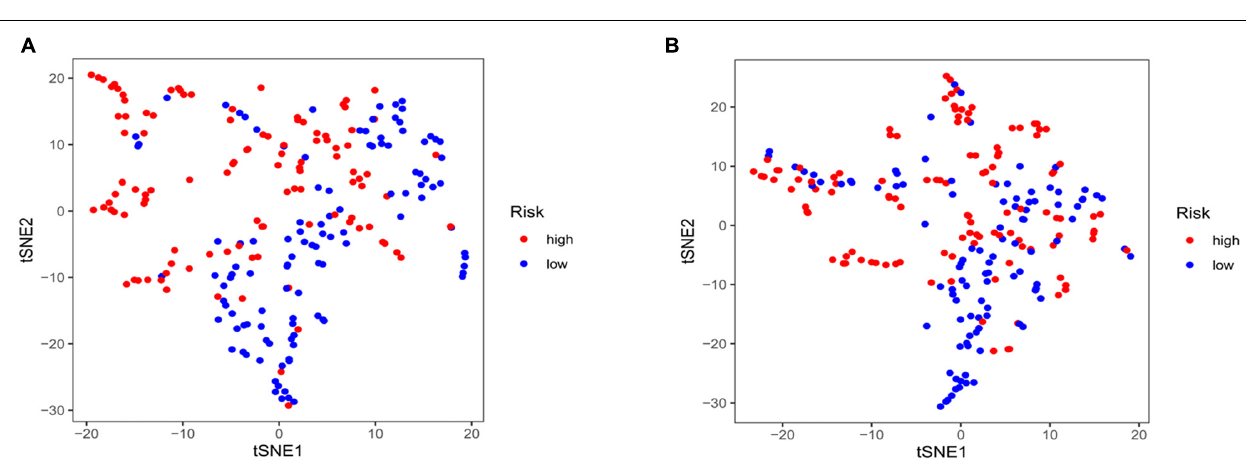
FIGURE 4 | T-distributed stochastic neighbor embedding analysis. (A) Training and (B) validation